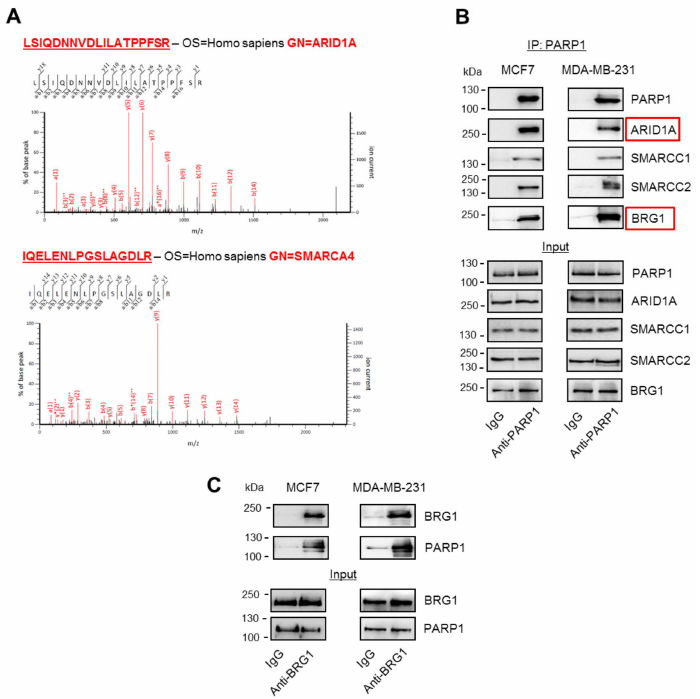
Figure 1. Poly-ADP-ribose polymerase 1 (PARP1) physically interacts with the brahma-related gene 1 (BRG1)-based SWI / SNF chromatin-remodeling complex. ( A ) Exemplar mass spectrometry (MSMS; representative peptides from three biological replicates visualized in Mascot) data for the identification of ARID1 and SMARCA4 as PARP1 interactors using PARP1 immunoenrichment. ( B ) PARP1 interaction with ARID1A, SMARCC1, SMARCC2, and SMARCA4 / BRG1 was confirmed by PARP1 pull-down and protein detection by Western blotting in cell lysates of two breast cancer cell lines, MCF7 and MDA-MB-231. IgG served as an isotypic control. ( C ) PARP1 was also identified in BRG1 immunoprecipitates. Western blotting images show representative images of three biological, fully reproducible